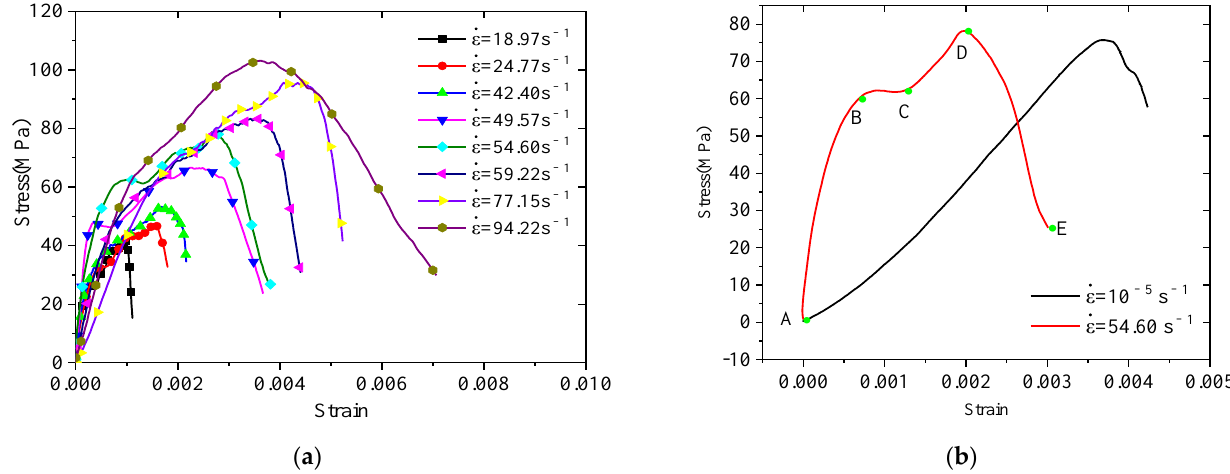
Figure 5. The stress–strain curves of sandstone specimens. ( a ) Dynamic stress–strain curves of sandstone specimens under different impact velocities. ( b ) Comparison between the typical dynamic and static stress – strain curves of sandstone specimens.